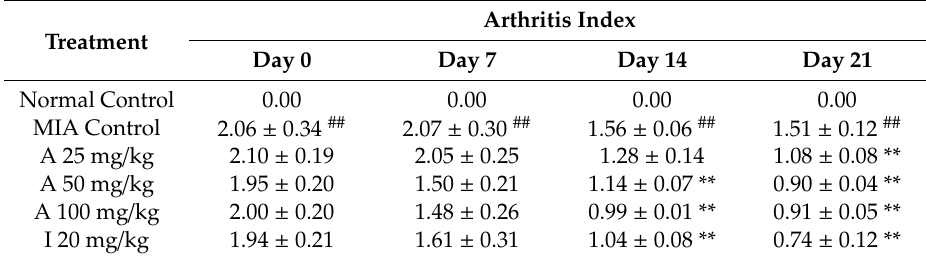
Table 2. Effects of AyuFlex ® on arthritis index (AI) for 21 days in MIA-incurred OA in rats. The results are expressed as the mean ± SEM ( n = 8/group). A, AyuFlex ® ; I, Ibuprofen. ** p < 0.01, in comparison with the MIA-induced control group; ## p < 0.01, in comparison with the non-MIA induced control group. Treatment